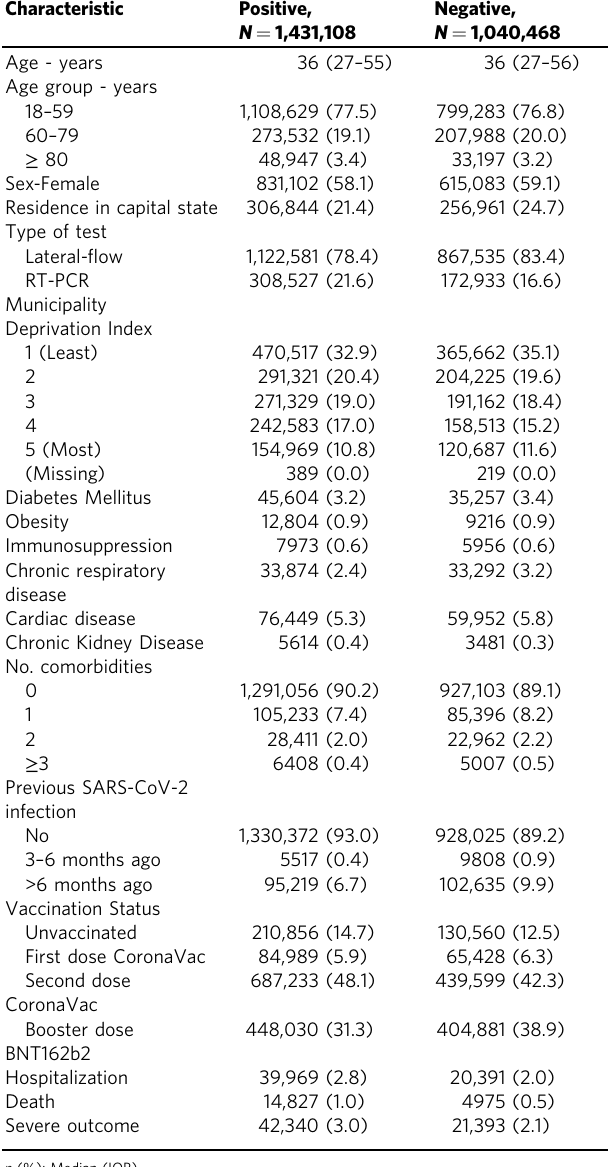
Table 1 Clinical and sociodemographic characteristics of individuals tested by SARS-CoV-2 RT – PCR or Rapid